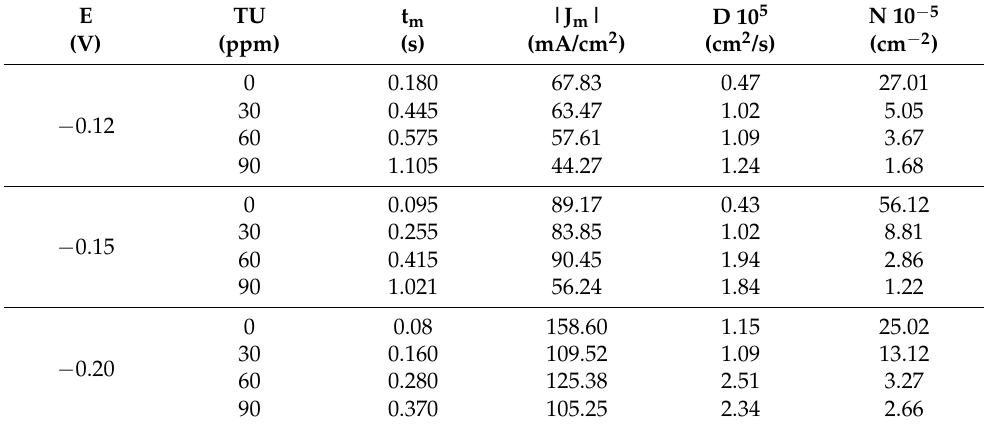
Table 1. Kinetic data obtained from the Scharifker–Hills model for the nucleation of copper at various deposition potentials and in the presence of different amounts of TU. The number density of the active sites, N, and diffusion coefficient, D, are